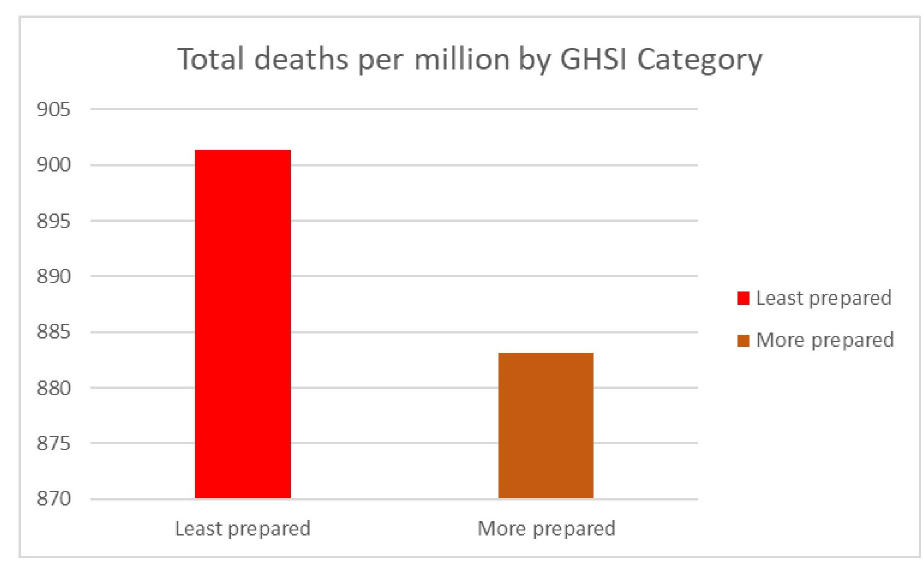
Fig 6. Total deaths by GHSI category.